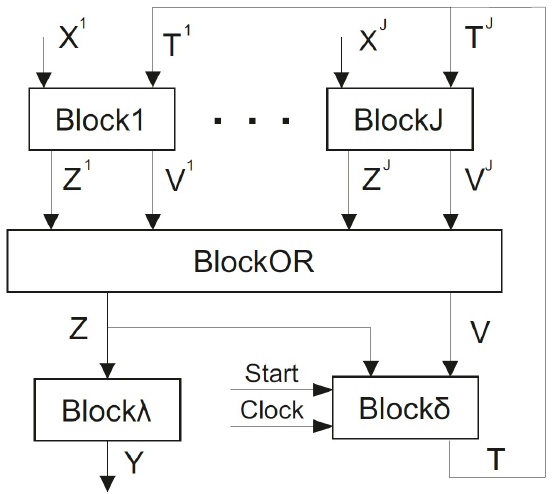
Figure 6. Architecture of Mealy FSM U 4